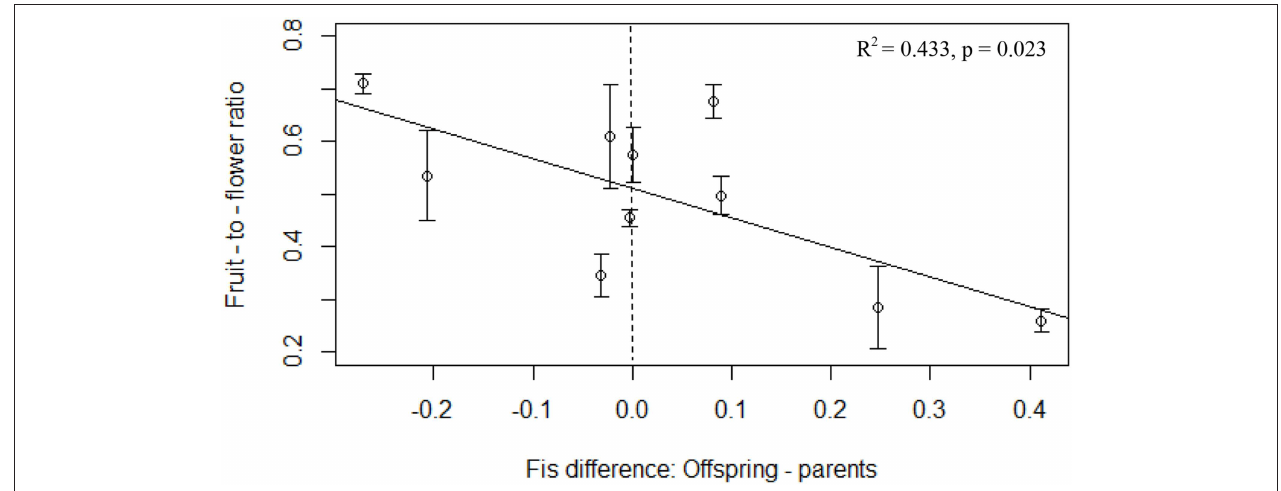
FIGURE 3 | Fruit-to-flower ratio in the maternal P. hirsutus populations decreased with the generational difference in F IS . Populations represented by points to the right of the vertical dashed line have more inbreeding in the offspring generation than in the parental generation while those to the left of the line experienced more inbreeding in the parental than the offspring generation. Error bars depict standard error of the mean.